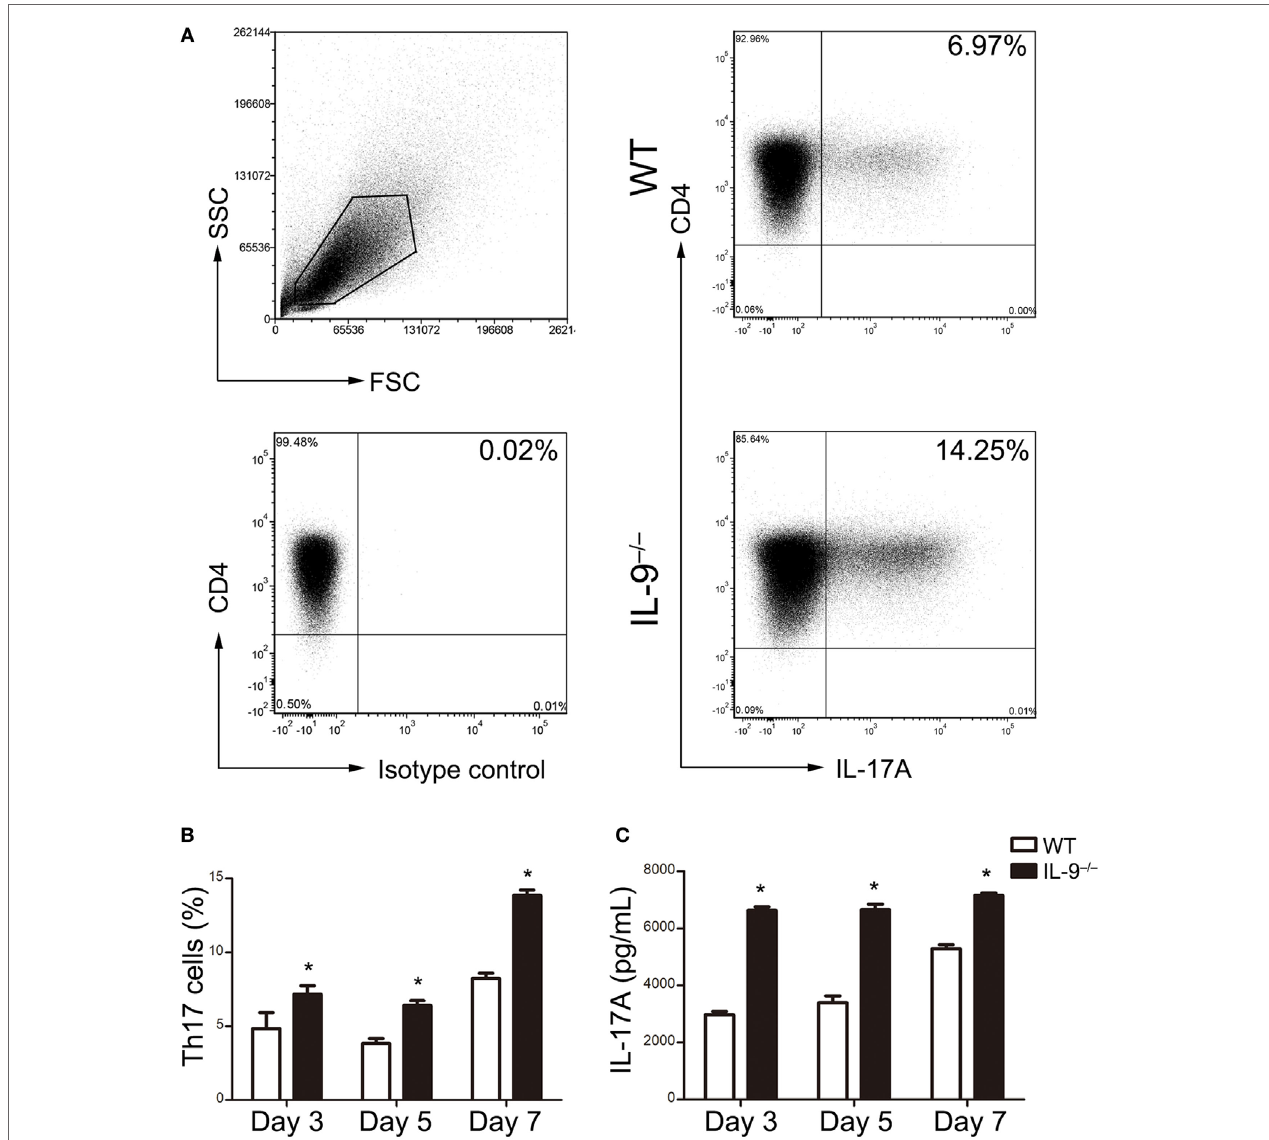
FigUre 3 | IL-9 deficiency enhanced T-helper (Th)17 cells differentiation in vitro . Naive CD4 + CD62L + T cells were purified from splenocytes of 8-week-old WT and IL-9 ‒ / ‒ mice and cultured under Th17 differentiation condition (as described in Section “Materials and Methods”). Cells were obtained on day 3, 5, 7 and assessed for IL-17 expression by flow cytometry. The culture supernatants were measured for IL-17A concentration by ELISA. (a) Representative flow cytometric dot plots were presented to show the Th17 cells differentiated from naive CD4 + T cells on day 7. Comparisons of Th17 cell percentage (B) and IL-17A concentrations (c) were demonstrated between WT and IL-9 ‒ / ‒ mice. Data were presented as mean ± SEM of three to four samples per group from three independent experiments. * P < 0.05 compared to WT group at corresponding day by Student’s t